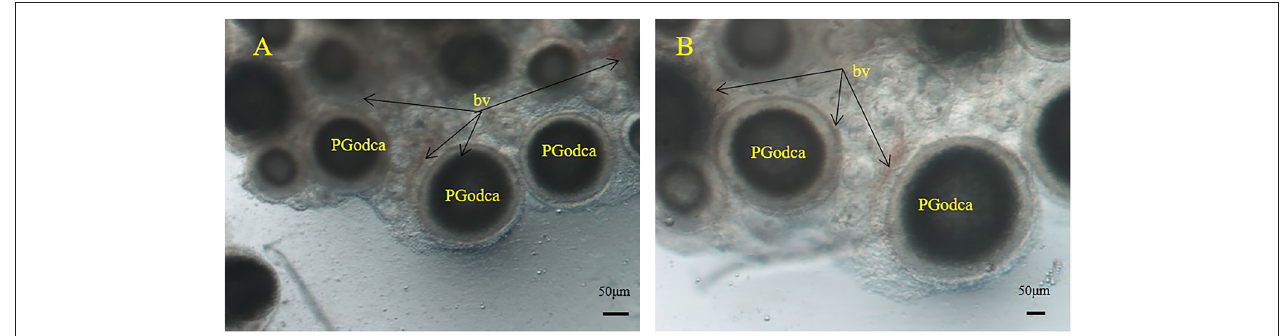
FIGURE 1 | S. schlegelii oocytes during the primary and secondary growth stages in ovaries. (A,B) Blood vessels (bv) surround oil droplet-cortical alveoli oocytes (PGodca). Scale bars, 50 µ m (A,B) .